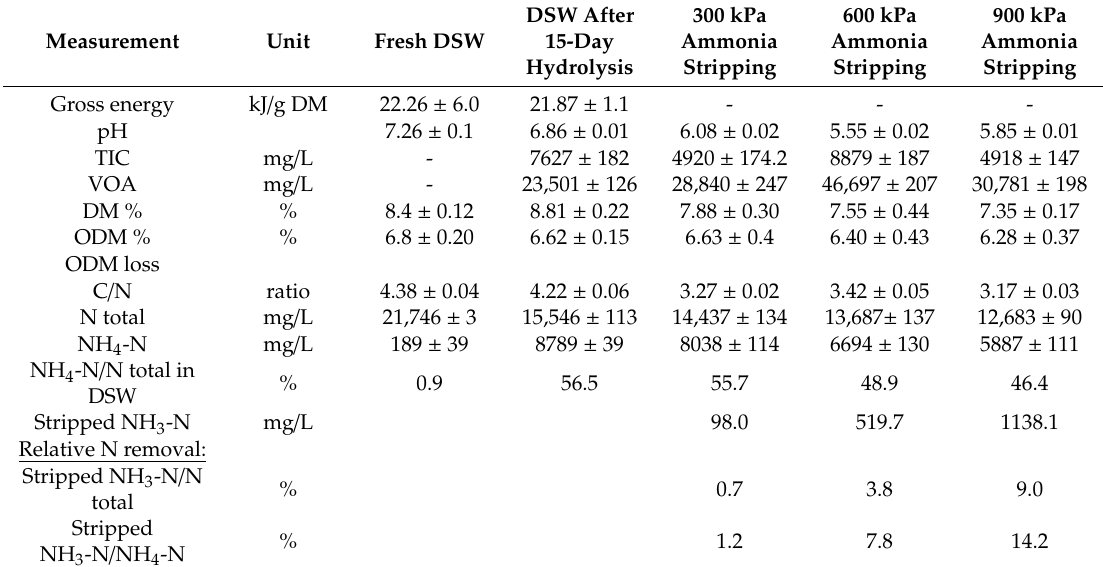
Table 2. Changes in the diluted SW (DSW) during the hydrolysis and fermentation and the follow-up ammonia stripping under different pressures. Measurement